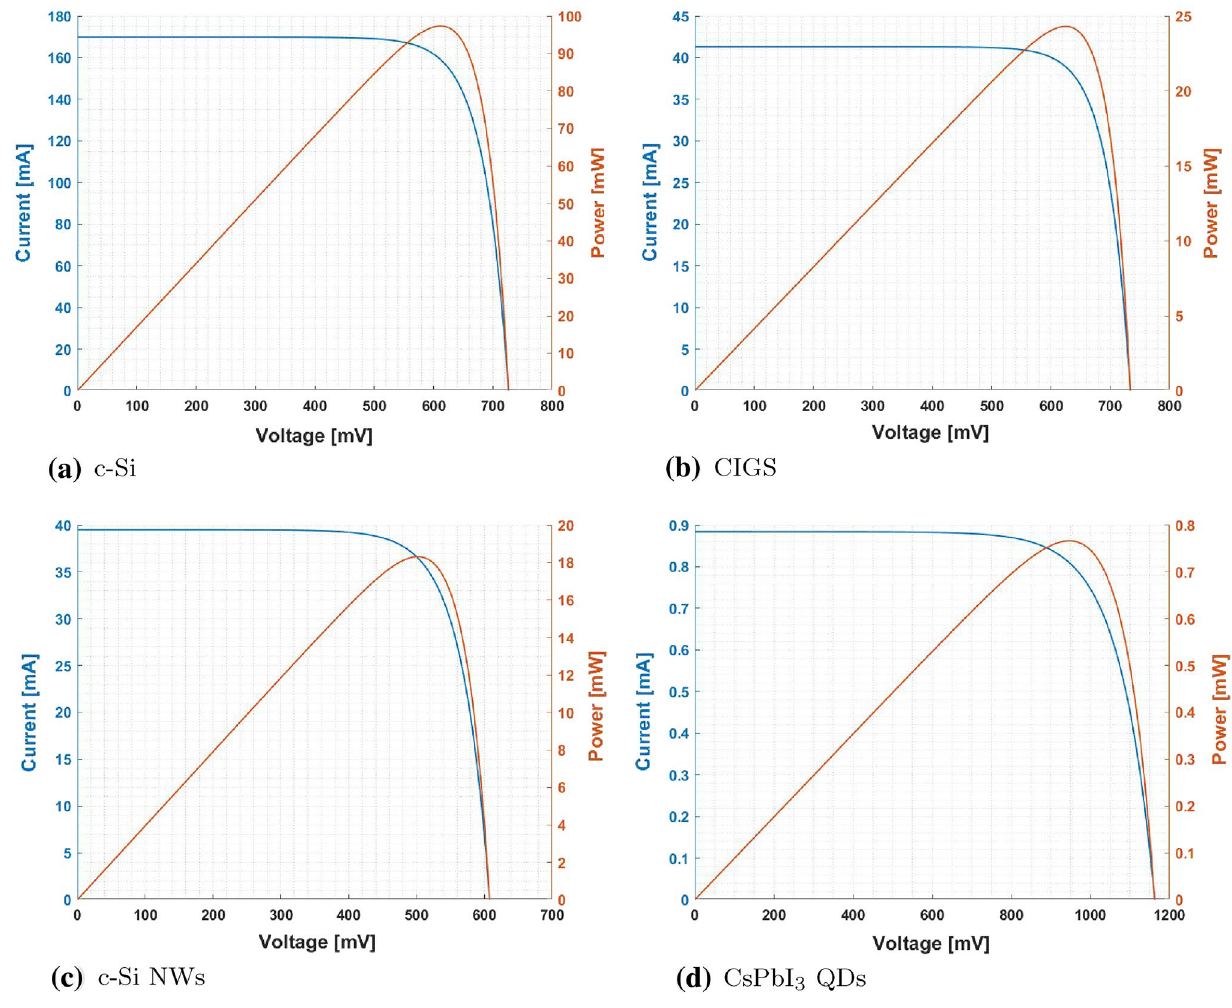
Fig. 2 Solar cells’ characteristics curves